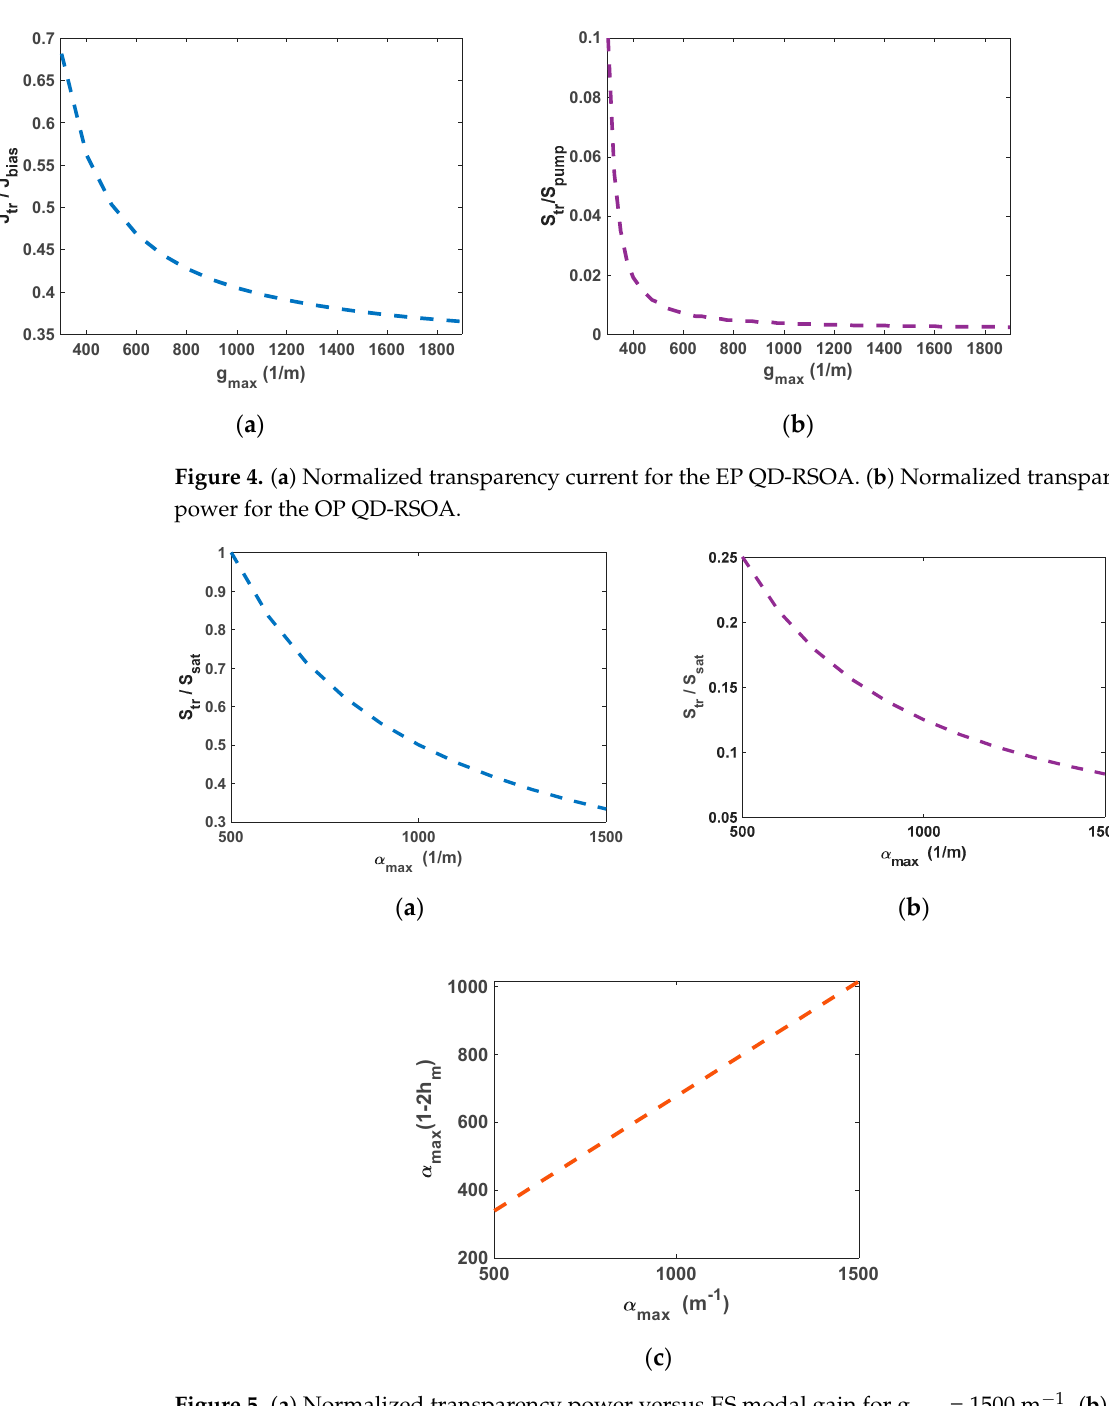
Figure 5. ( a ) Normalized transparency power versus ES modal gain for g max = 1500 m − 1 . ( b ) Normalized transparency power versus ES modal gain for g max = 1900 m − 1 . ( c ) The term α max (1–2 h m ) versus ES modal gain.